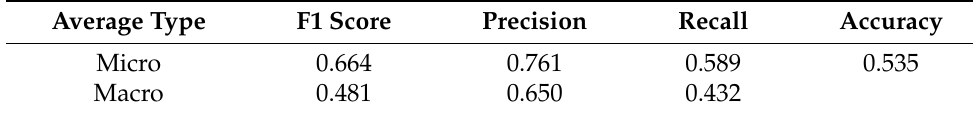
Table 3. Overall results of the the model on the 2018-E-c-En-test-gold dataset.